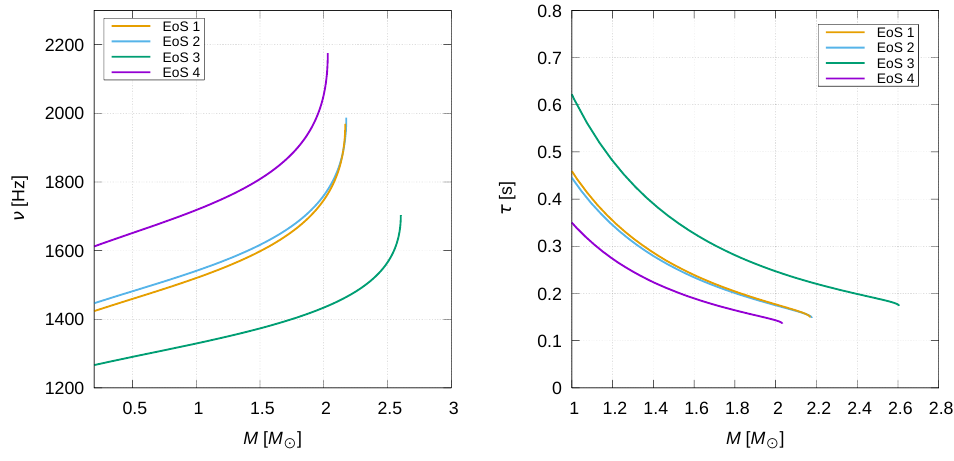
Figure 7. ν –mass ( left panel) and τ –mass ( right panel) relationships for the sets of Table 2. Continuous curves represent low-MF QSs, and dotted curves represent magnetars. Due to the negligible effects of the MF on the QS structure, both astrophysical scenarios are indistinguishable (see enlarged Figure 8 for details). It can be seen that the EoS producing the highest maximum mass results in the lowest frequency values and longest damping times.